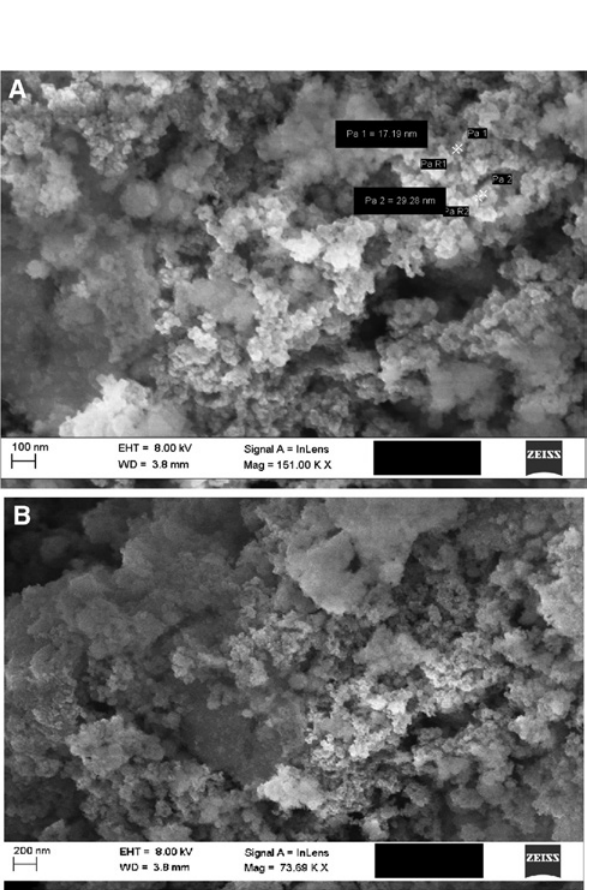
Figure 4: (A) SEM of nanosized Ni-LDH, (B) SEM of nanosized Cu-LDH.